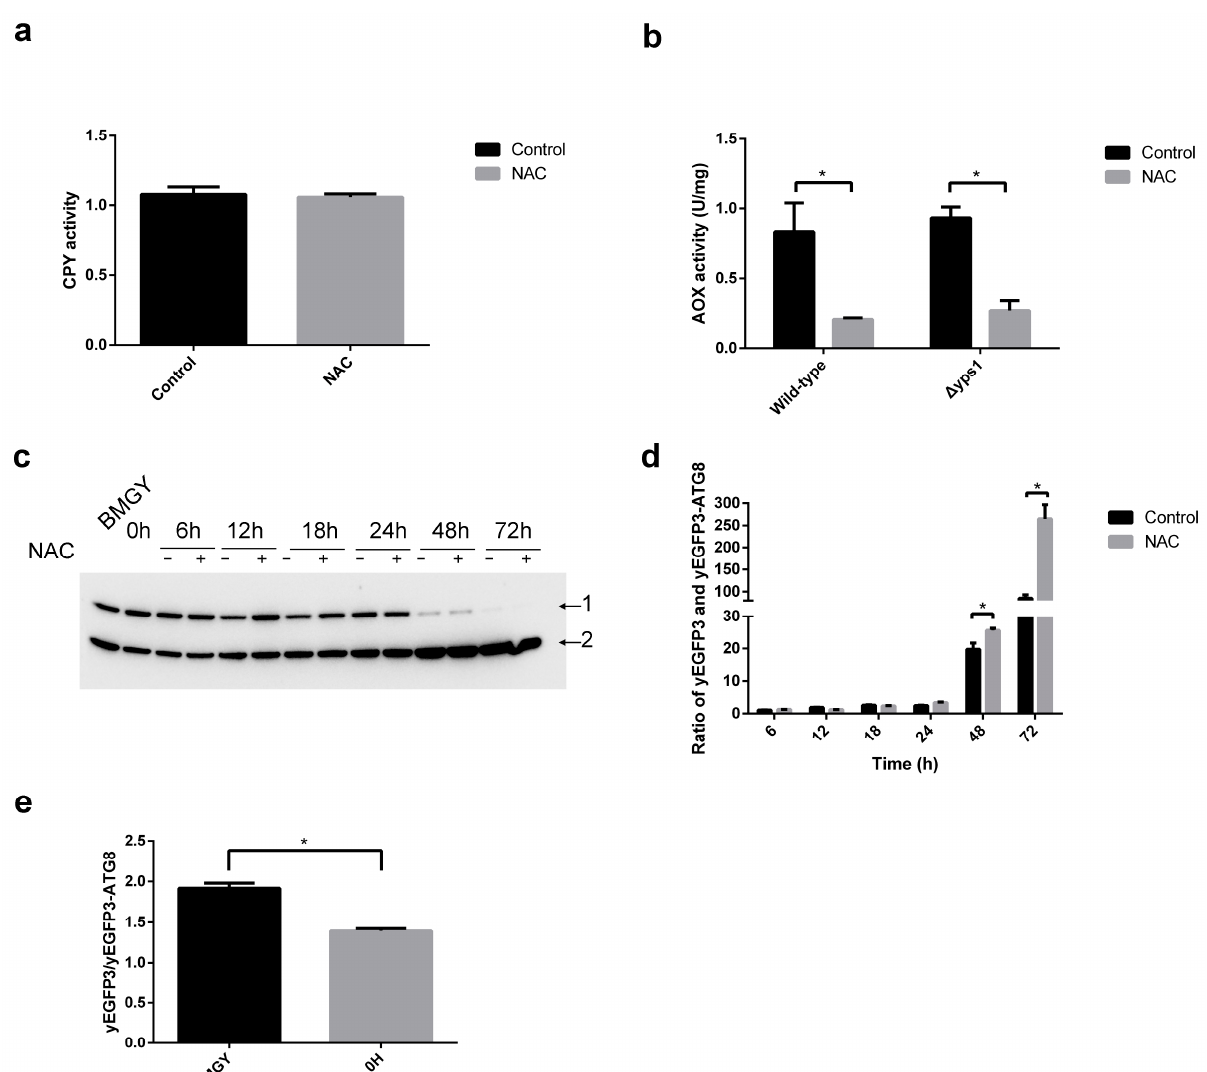
Figure 4. Determination of autophagy in cell treated with NAC. ( a ) Carboxypeptidase Y (CPY) activity detected in F strain treated with NAC. ( b ) Alcohol oxidase (AOX) activity measurement. The activity of AOX in F and ∆ yps1 strains supplemented with or without NAC was measured. ( c ) Western blot analysis of GFP in FATG8 strain that overexpressed yEGFP3-ATG8 in F strain. Moreover, 0 h is defined as the time of cells transfer into the BMMY. Arrow 1: yEGFP3-ATG8, arrow 2: yEGFP3. ( d , e ) The relative amounts of protein bands in Figure 4c were estimated using Image J analysis software. The results presented in the histogram reflect the fold-change in yEGFP3 and yEGFP3-ATG8. p values were calculated using Student’s two-tailed t -test with p < 0.05 considered statistically significant (Marked with *). Error bars represent means ± standard deviation (SD) (n = 3). Table 1. Recombinant strains of Pichia pastoris in this study.